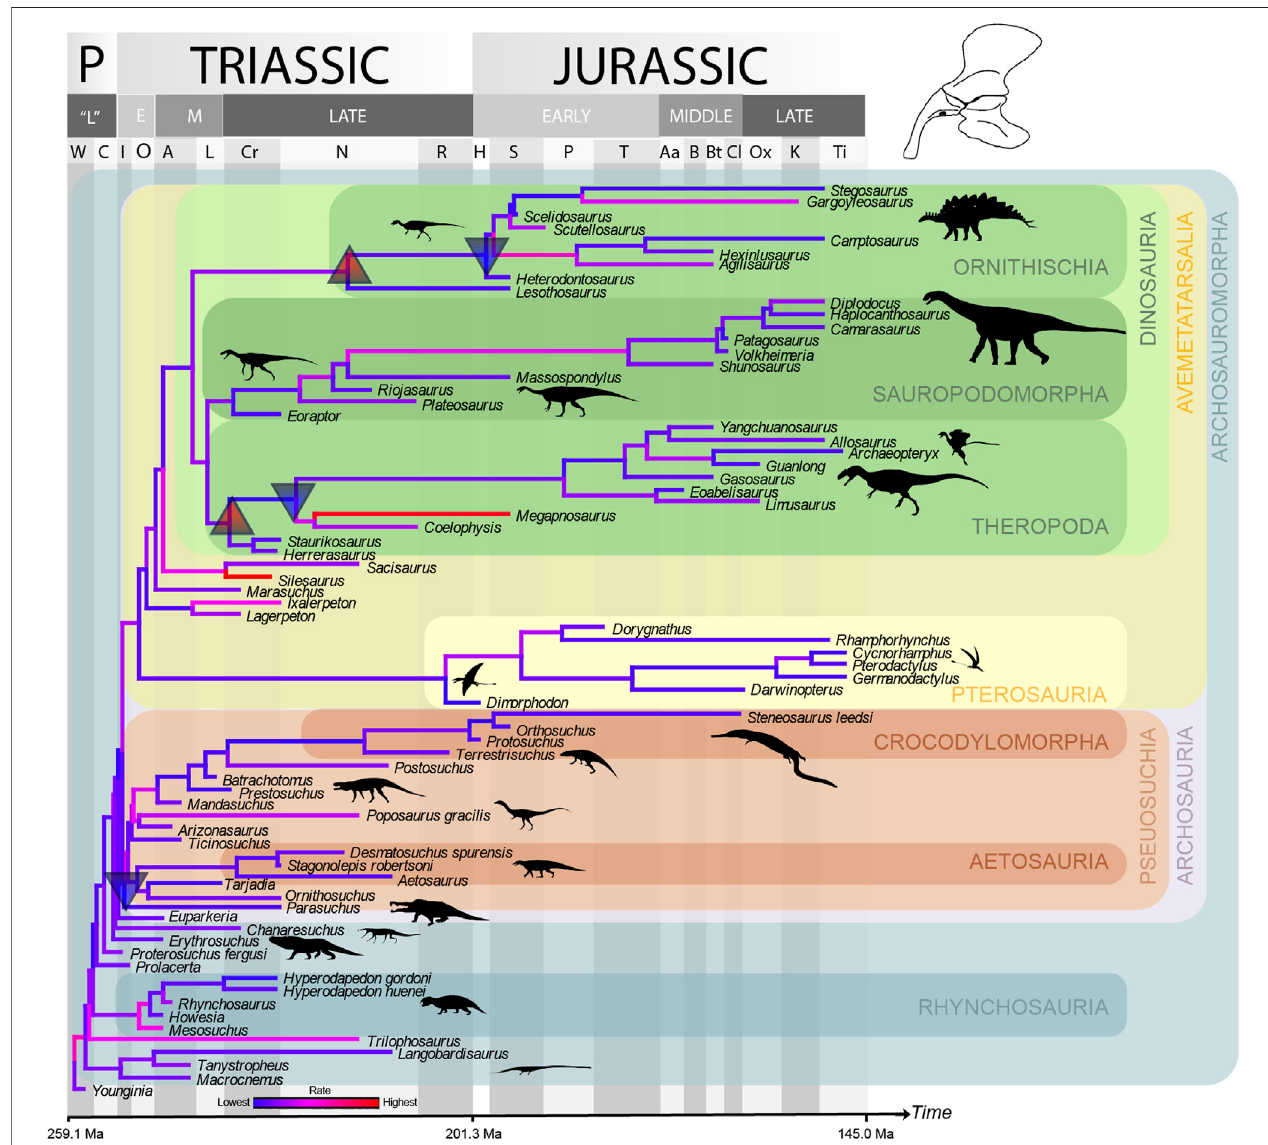
FIGURE 11| Results for evolutionary rate and rate shift analysis for the pelvis for 2D geometric morphometric shape for archosauromorphs from the Permian-Late Jurassic for a single randomly chosen, range-dated tree from the treeset of 1,000 trees. Results differed across trees, especially with range dating — full results are reportedinthetextand giveninthe Supplementary Material .Rates tendedtobehigherinitiallyand slowdown withinclades, withsign fi icantdownshiftsnearthebase of clades, often preceding upshifts slightly “ stemward ” of these. Redder branch colors indicate higher rates and bluer branch colors lower rates. Blue downward arrows indicate signi fi cant decreases in rate. All silhouettes taken from www.phylopic.org.